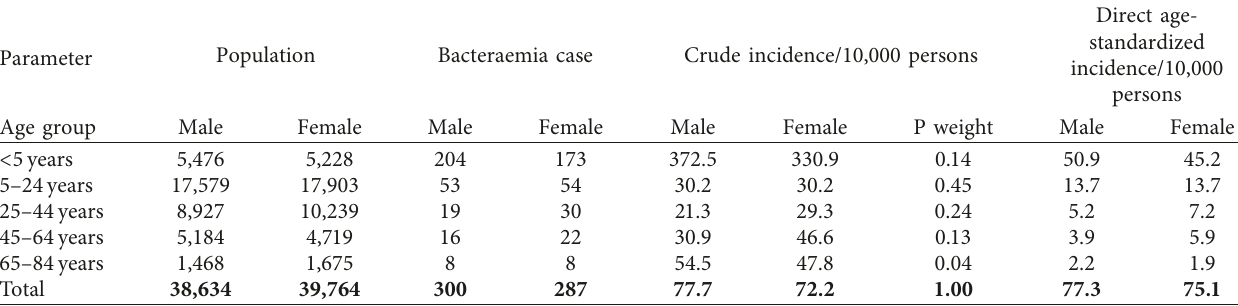
Table 1: Age- and gender-stratified crude incidence of bacteraemia among the population of patients seeking healthcare at St. Dominic Hospital, Akwatia, Ghana.